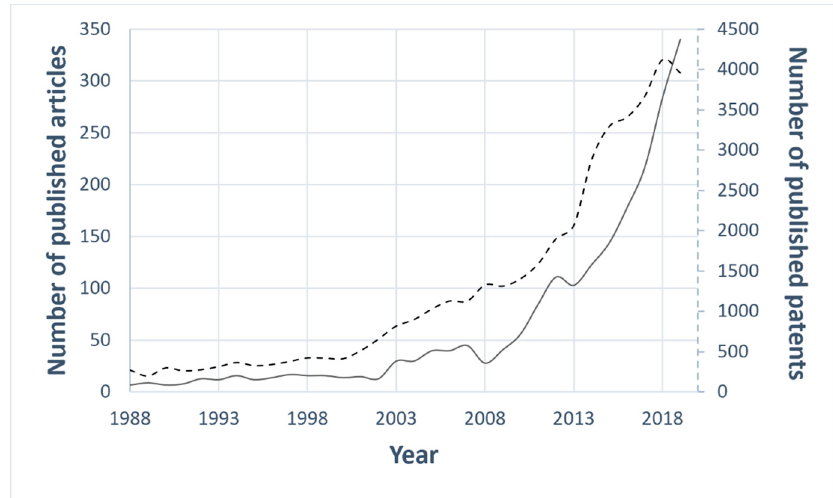
Figure 1. The statistics of the published articles indexed in Scopus (black line) and of the published patents listed in Espacenet [15] (black dotted line) on the topic of “anti-icing”. Year range selected: 1988–2019.